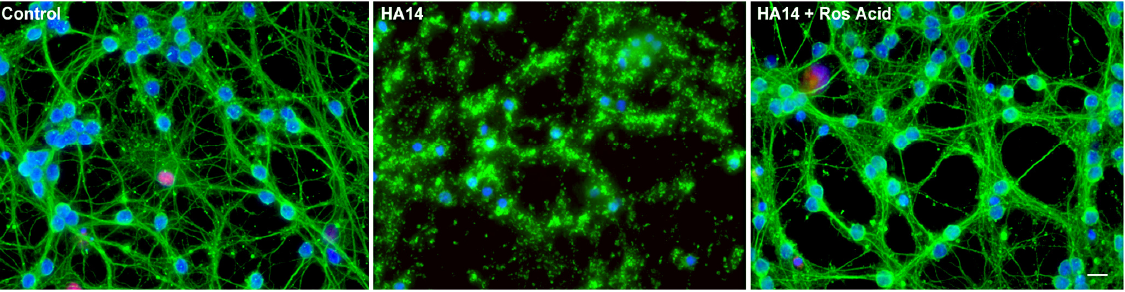
Figure 3. Rosmarinic acid protects neurons from oxidative stress. Representative images of CGNs incubated for 24 hrs with the Bcl-2 inhibitor HA14-1 (15 M), HA14-1 + rosmarinic acid (Ros Acid; 50 M), or no treatment (Control). Immunocytochemistry was performed for β -tubulin (green) and active caspase-3 (red). Nuclei are stained with DAPI, blue. Scale bar; 10